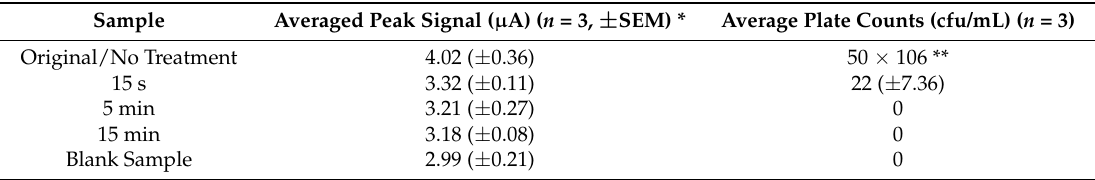
Table 2. Ultraviolet-C (UV-C)-treated E. coli . O157:H7 electrochemical signal and plate counts. Sample